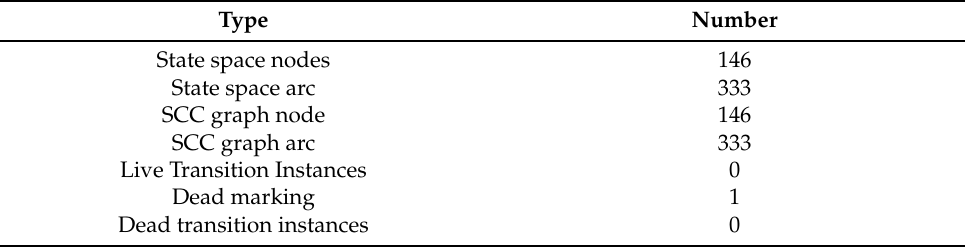
Table 2. State space analysis of the original model of SOME/IP